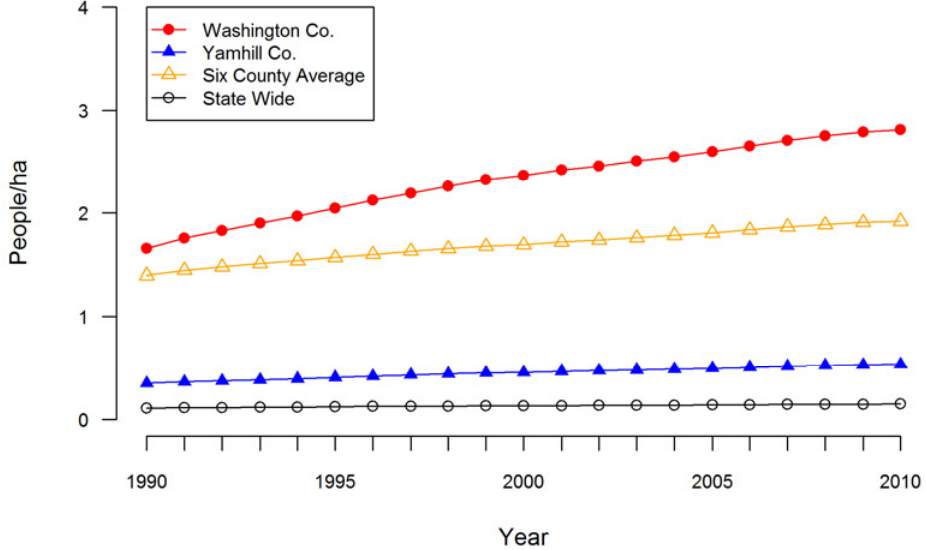
Figure 2. Annual increase in population density (people/ha) for two counties.